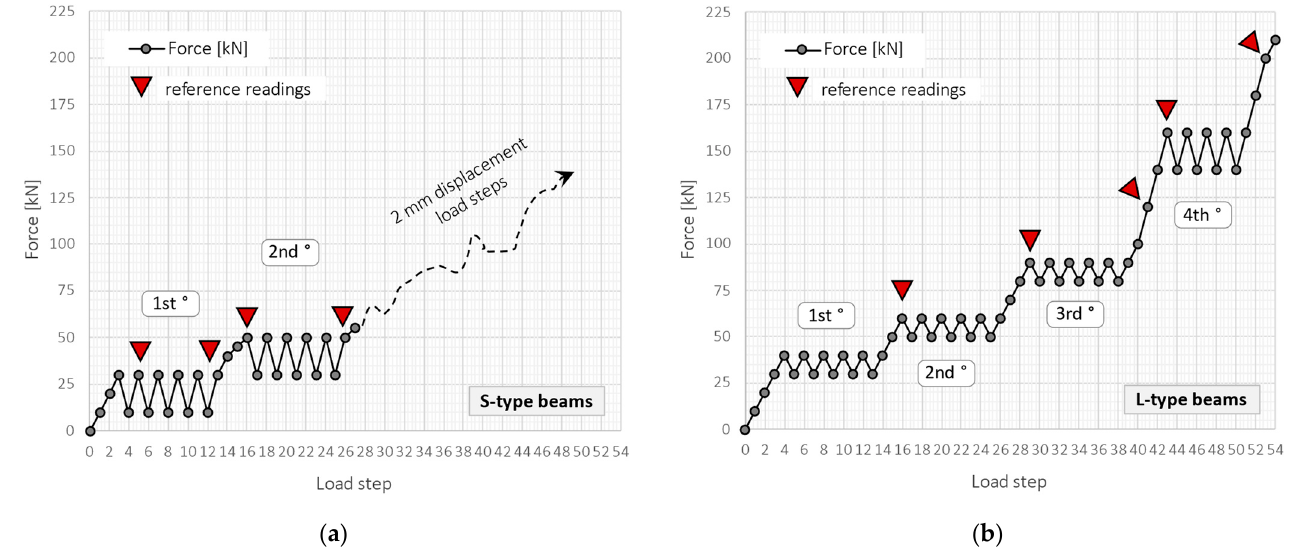
Figure 18. The loading schedule for ( a ) S-type and ( b ) L-type beams.